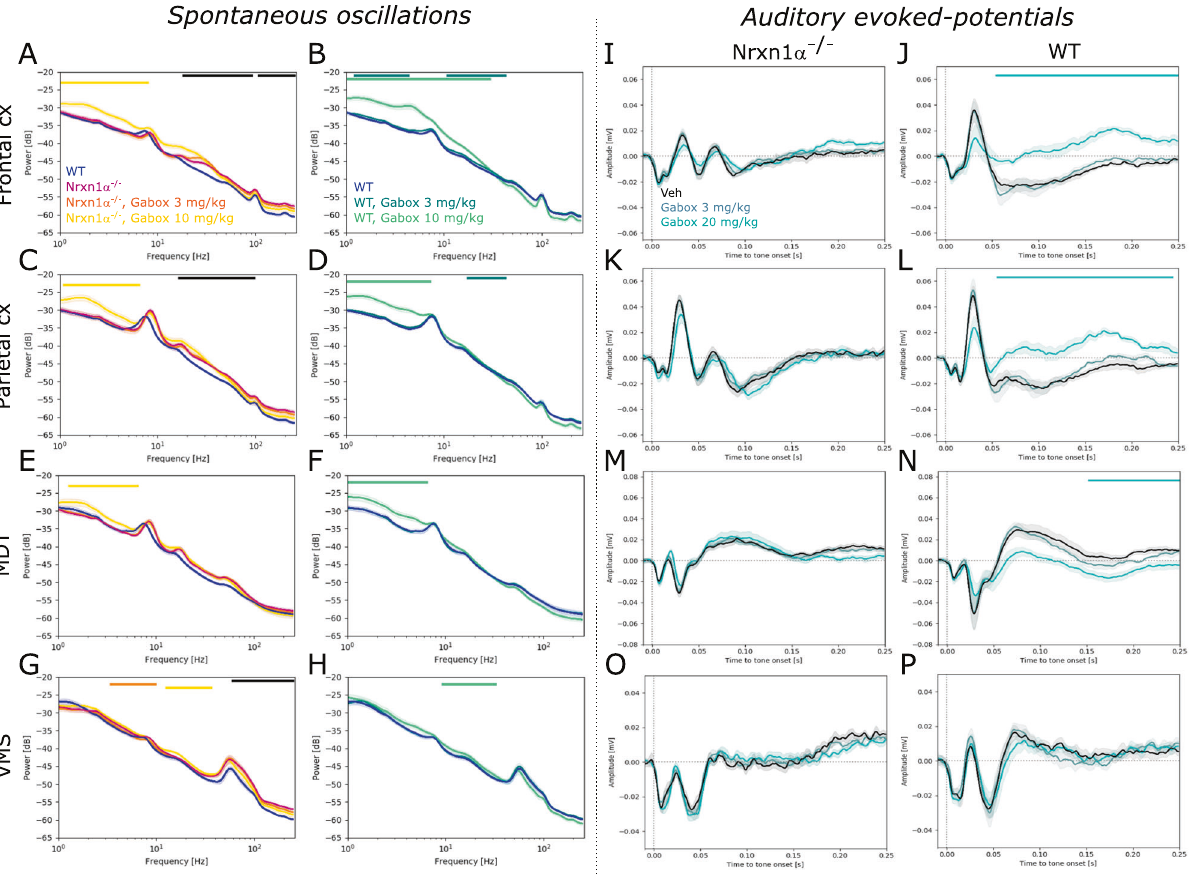
Fig. 6 Effects of GABA A δ receptor-mediated tonic inhibition on oscillatory activity and auditory-evoked responses. A – H Power spectral density plots showing the effect of Gaboxadol (3 mg/kg and 10 mg/kg) on oscillatory activity in Nrxn1 α − / − ( N = 10) and wildtype ( N = 7) rats, respectively. A , B Spectrograms for frontal cortex, C , D parietal cortex, E , F MDT and G , H VMS. I – P Effect of Gaboxadol on auditory-evoked potentials in Nrxn1 α − / − ( N = 10) and wildtype ( N = 7) rats. I , J Average fi eld potentials for frontal cortex, K , L parietal cortex, M , N MDT and O , P VMS. Data displayed as mean + SEM and tested with unpaired CBPT (for between genotype comparisons) and paired CBPT (within genotype across condition comparisons). Colored bars above the graphs represent clusters with statistically signi fi cant differences (black: Nrxn1 α − / − vs. WT; other colors according to the